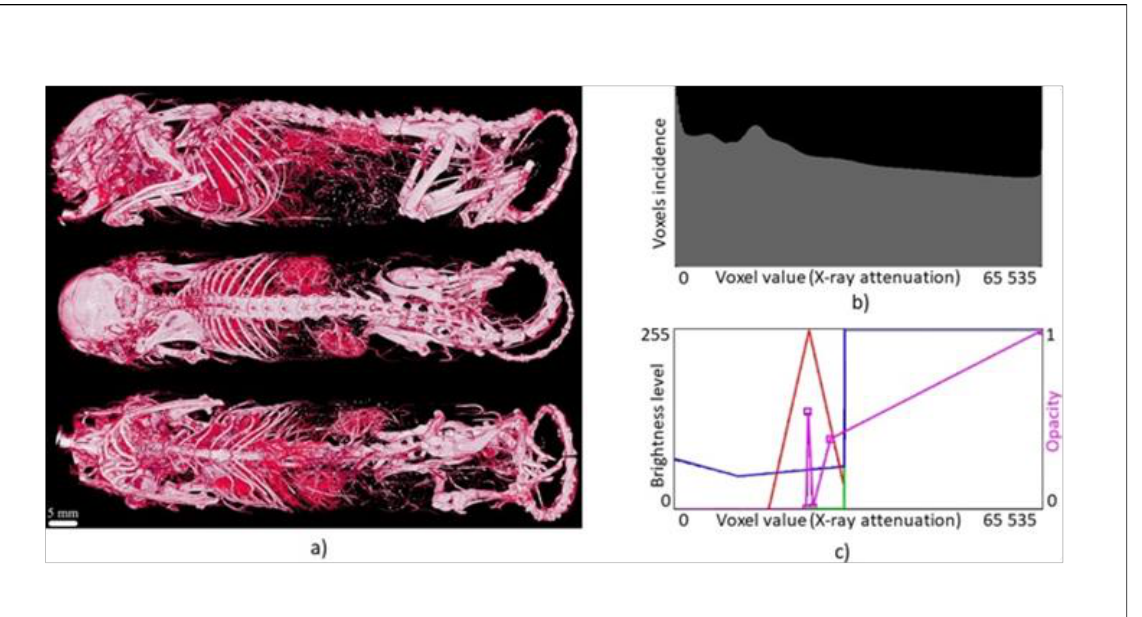
Figure 9 . Transfer functions design — ( a ) mouse (Aurovist, 42 kV), ( b ) histogram, and ( c ) transfer Figure 9. Transfer functions design—( a ) mouse (Aurovist, 42 kV), ( b ) histogram, and ( c ) transfer functions (opacity, RGB). functions (opacity,